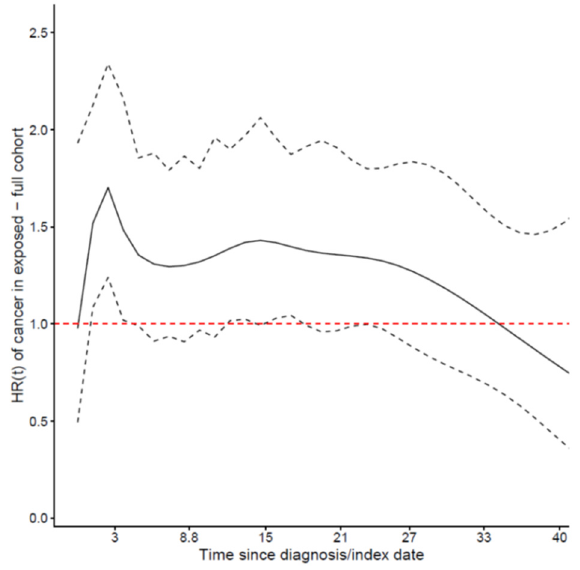
Figure 2. Solid line shows the time-dependent hazard ratio HR(t) of new primary cancer among posterior uveal melanoma patients with respect to the unexposed comparisons in relation to time since diagnosis/index date (years) (adjusted analyses, full cohort). The dotted line shows the 95% confidence intervals. Table 4. Time-dependent hazard ratios of new primary cancer following the diagnosis of posterior uveal melanoma.